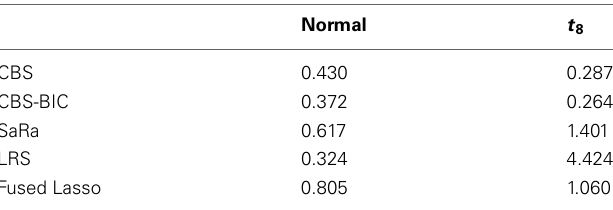
Table 1 | Average number of false positive break points by error structure for simulation.